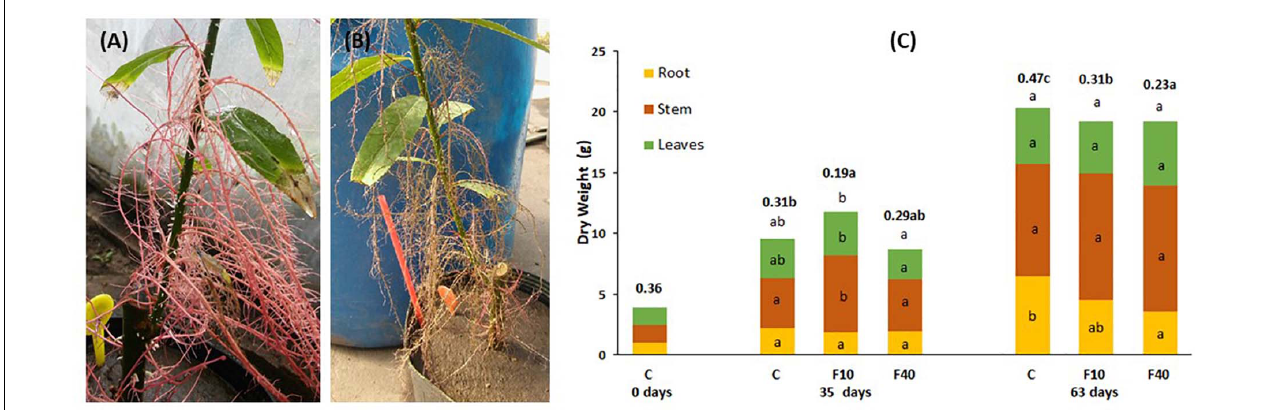
FIGURE 2 | Aquatic roots of a F40 plant immediately after taken out of water (A) and 24 h later (B) . (C) Dry matter partitioning and root-to-shoot ratio (in bold, above the bars) at the beginning of the experiment (day 0), at the end of the flooding period (35 days), and at the end of the post-flooding recovery period (63 days). Means followed by the same letter did not differ according to Tukey’s test ( p < 0.05, N = 5). The letters indicate significant differences for each compartment, total biomass (above the bar) and root-to-shoot ratio (next to this value, in bold).